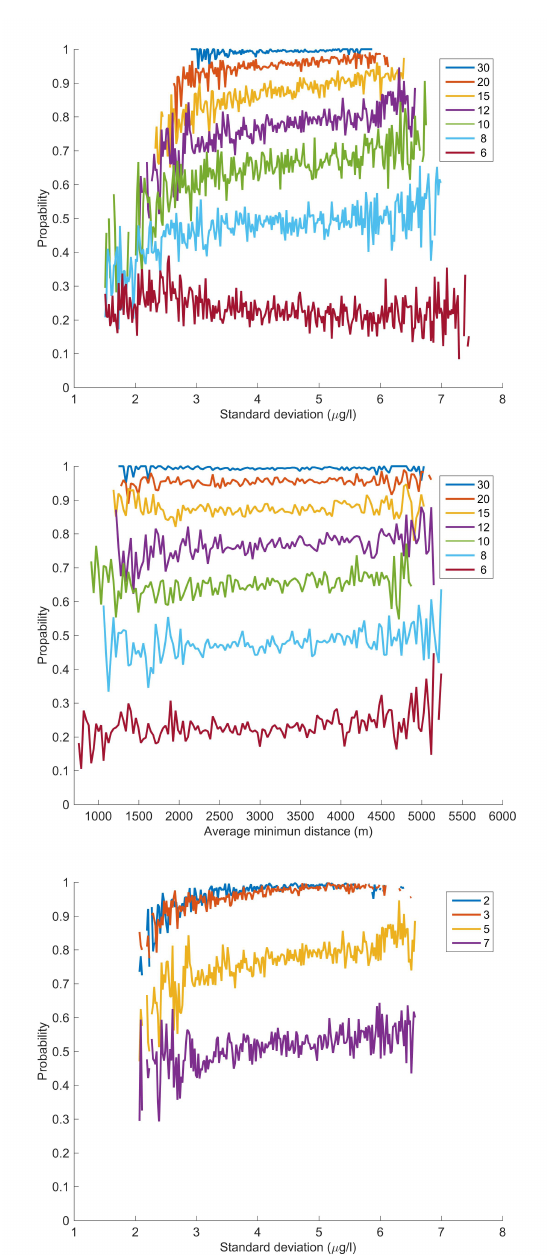
Figure 11. Probability that the correlation coefficient r > 0.7 for different number of randomly selected samples (top and middle figures) and number of wavelength bands used as variables (bottom). 5 bands used for top and middle figures and 12 randomly selected reference measurements for bottom figure